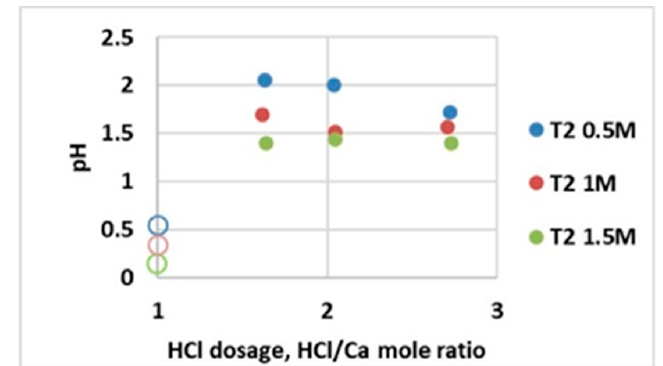
Figure 1. pH value depending on HCl dosage and concentration in the reaction with Toolse 2 sample: ○ before reaction; • after reaction.